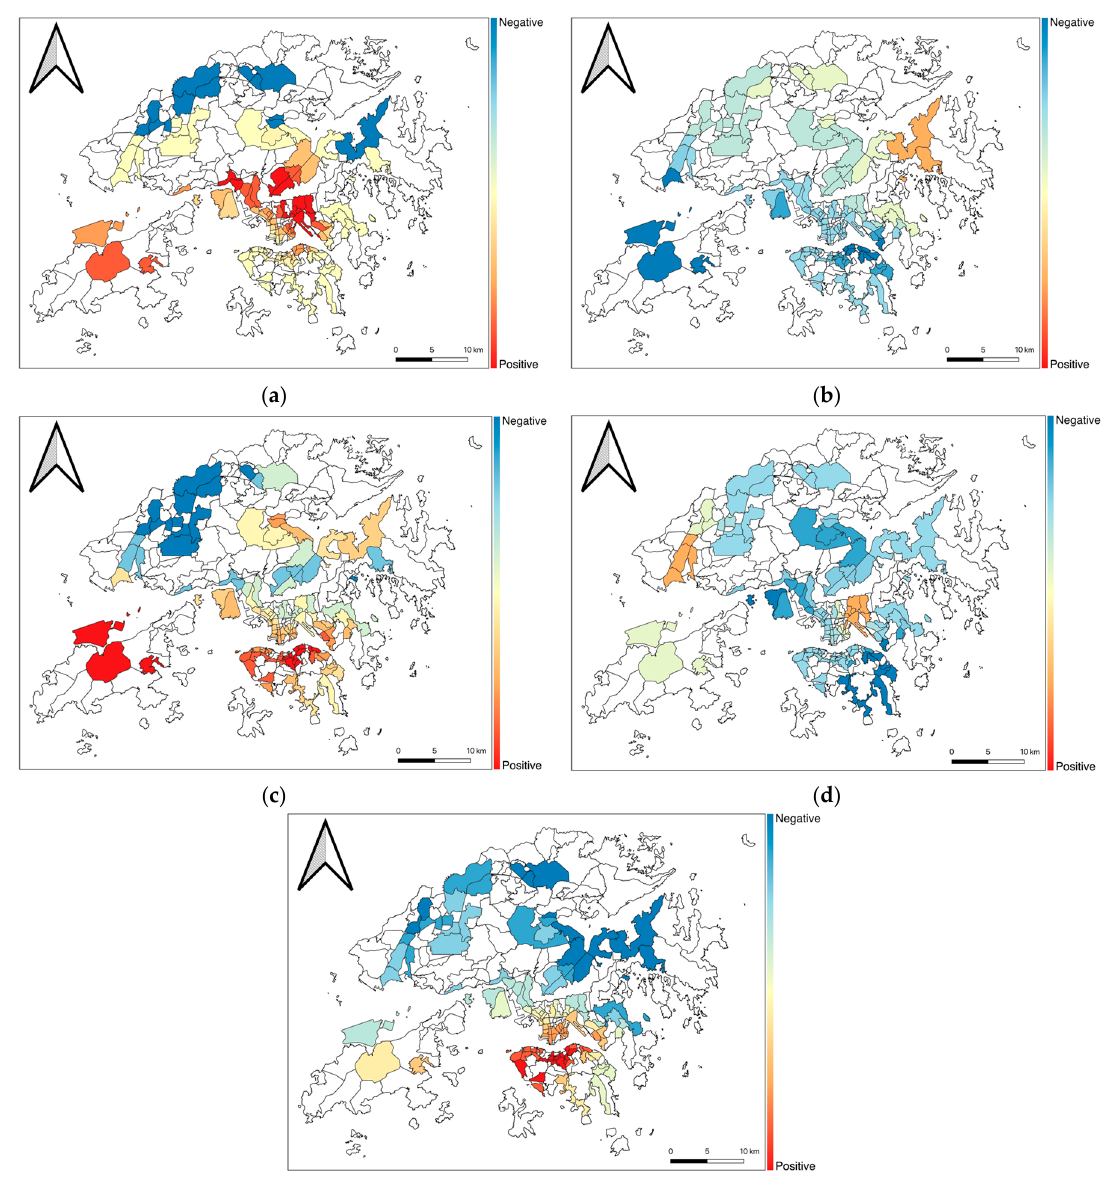
Figure 8. Spatial distribution of GWPR coefficients for R1: (a) Transport facility density; (b) Population density; (c) Private residential density; (d) Land-use diversity; (e) Building height.